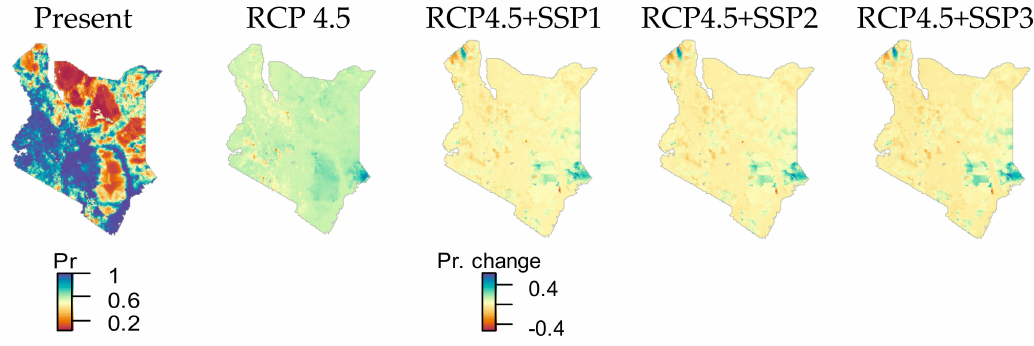
Figure 8. Present probability of occurrence of at least one species and changes in 2050, under RCP 4.5 and SSP scenarios.